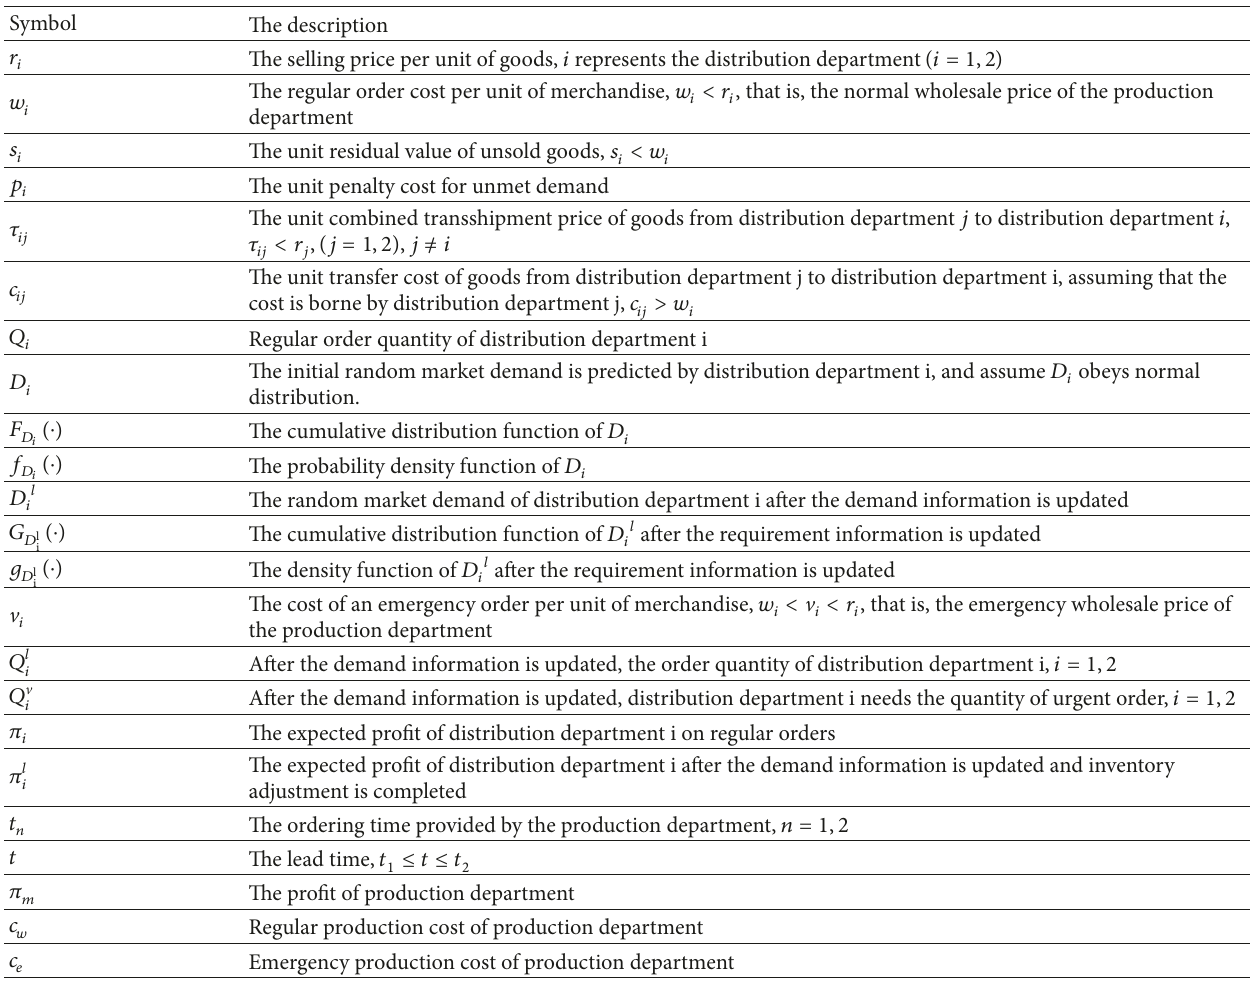
Table 1: The description of each